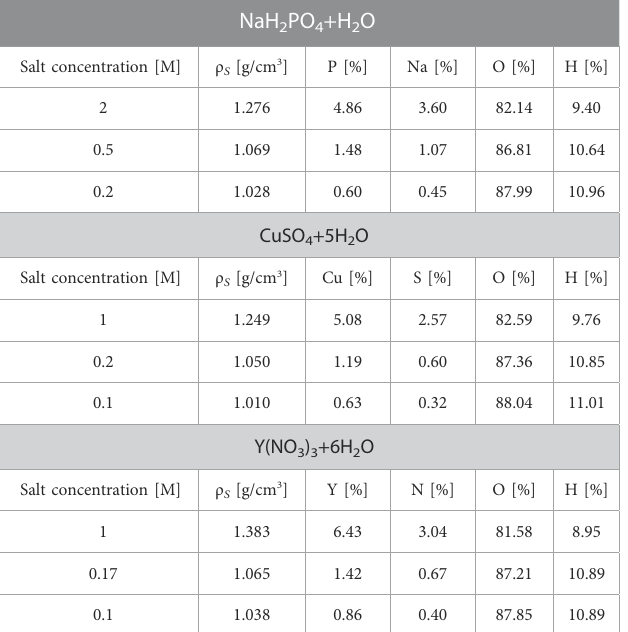
TABLE 1 List of the irradiated solutions at three different molar concentrations. Solution density ( ρ S ) and the elemental composition mass fraction is reported. Molar concentrations were chosen to achieve around the 5%, 1%, and 0.1% of element mass fraction in the solution. Uncertainties on the solutions mass fractionsdependsonthesolutionpreparation(weightofthesaltandwater),and have been estimated to be